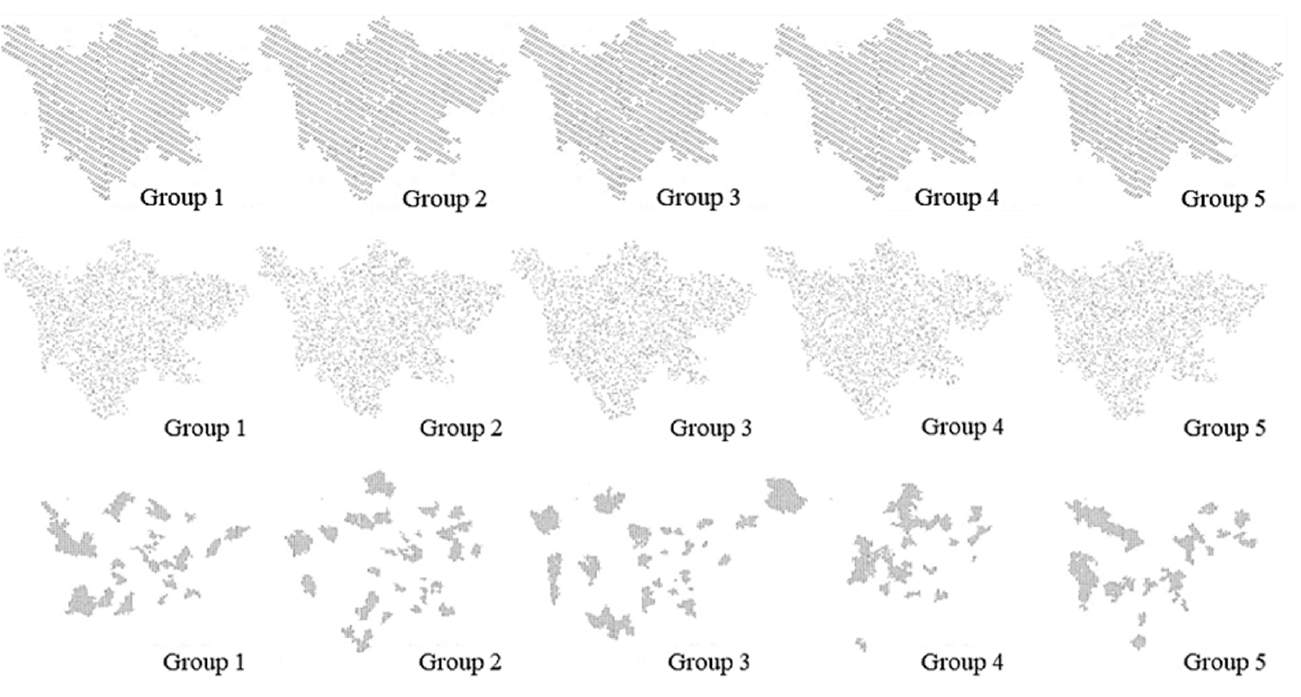
Figure 5. Grouping results obtained by systematic, random, and cluster sampling in the second stage.